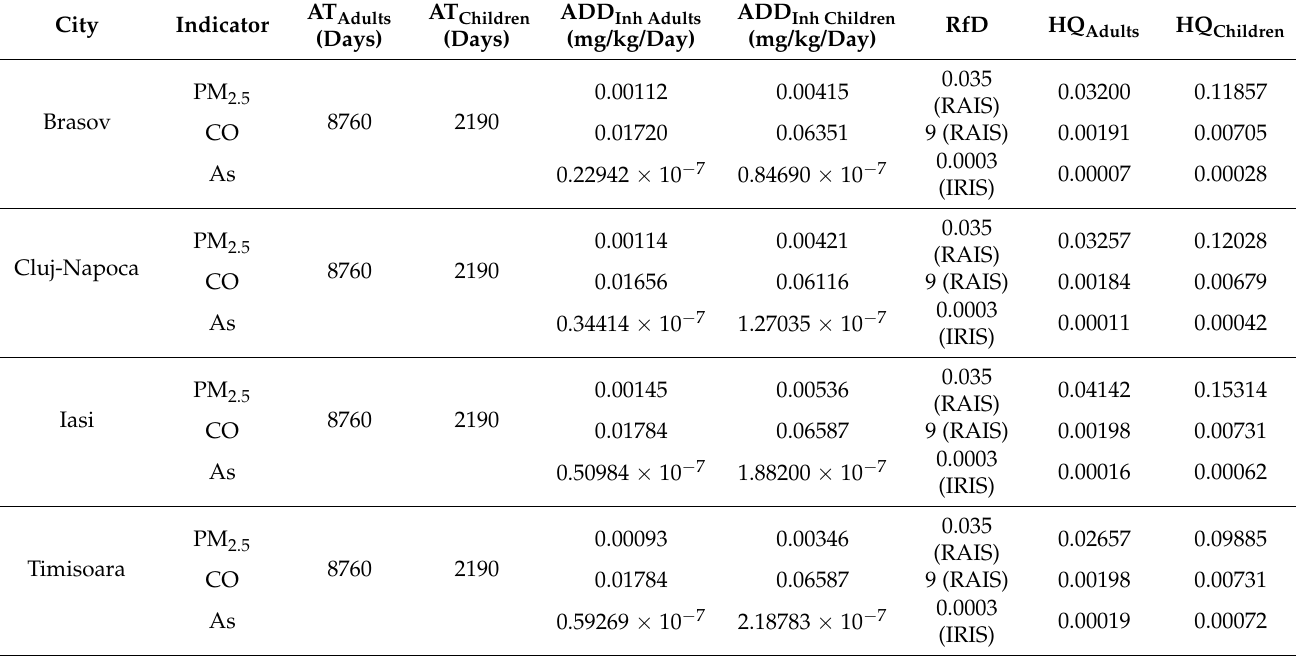
Table 3. Calculation of the average daily dose (ADD inh ) and the hazard coefficient